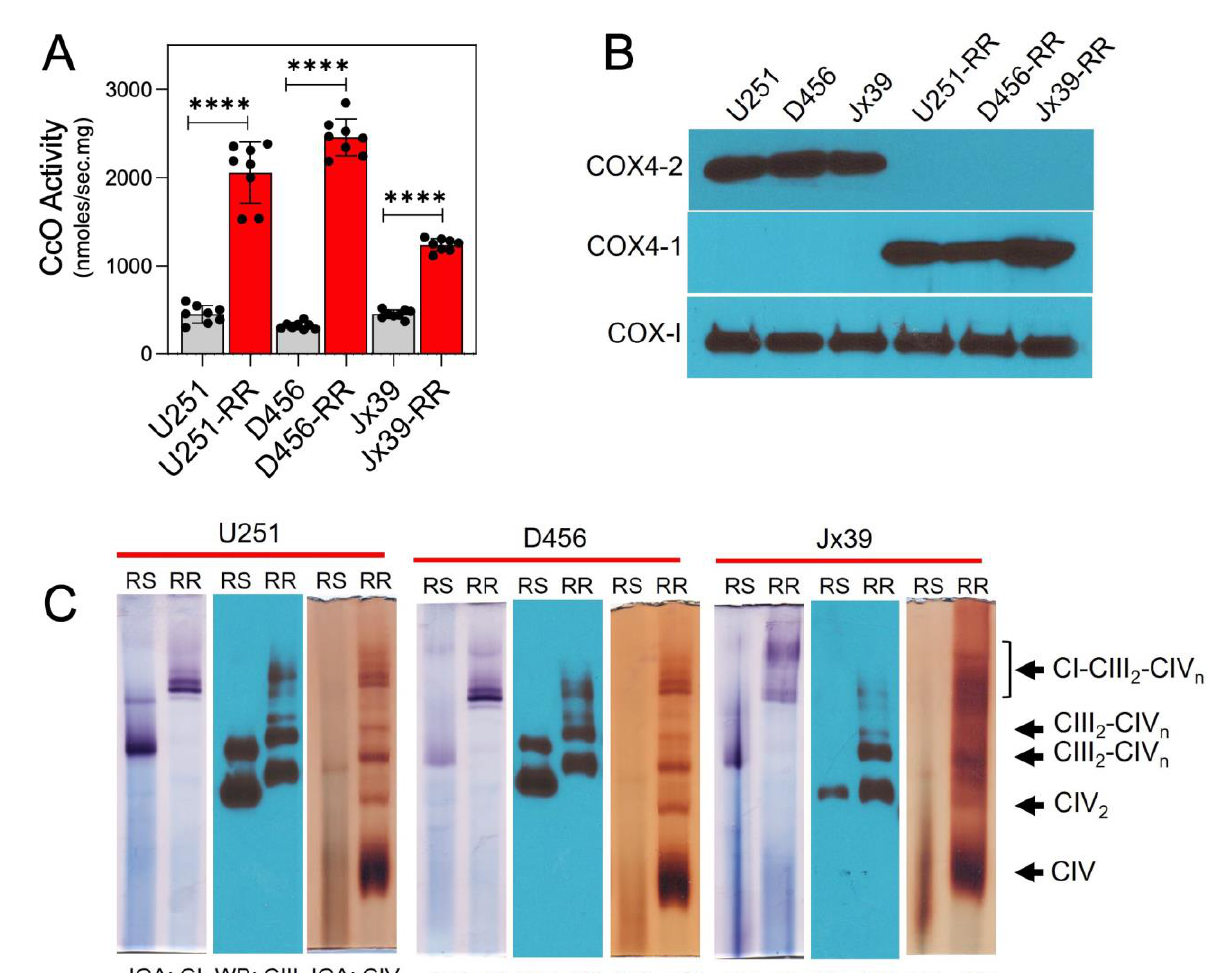
FIGURE 3: CcO is incorporated into mitochondrial SCs in GBM cells with acquired radioresistance. (A) CcO activity in radiosensitive (U251, D456, and Jx39) and isogenic radioresistant (U251-RR, D456-RR, and Jx39-RR) cell lines. Data are presented as the mean ± SEM (n=4). (B) Representative Western blot showing the expression of the COX4 isoforms COX4-1 and COX4-2 in the radiosensitive and radioresistant cells. COX-I was probed as a loading control. (C) Digitonin-solubilized mitochondria from radiosensitive and radioresistant cell lines were subject- ed to BN-PAGE followed by complex I and IV IGA assays and Western blot for complex III. Representative image from 3 separate experi- ments. p < 0.0001 (****), calculated by Student OPEN ACCESS | www.cell-stress.com